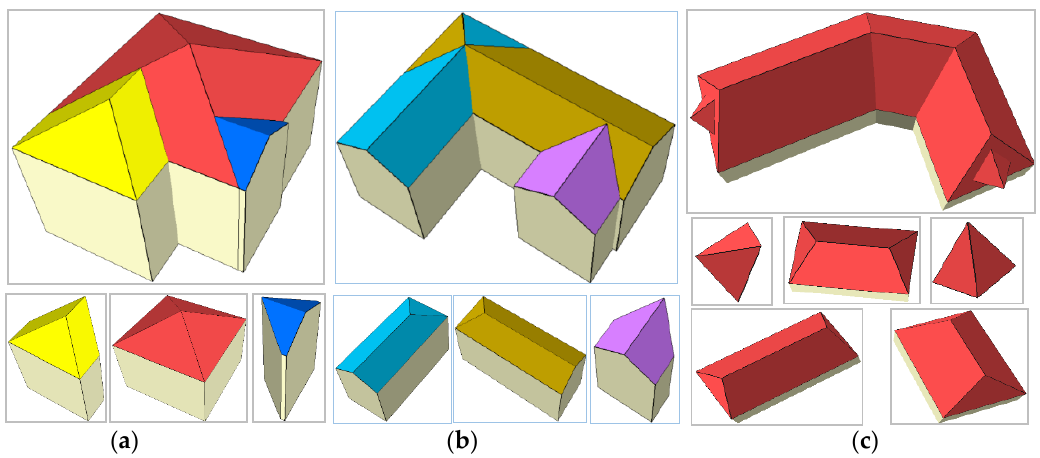
Figure 14. Results of roof reconstruction ( a – c ). Structural models ( top ) and its grouped structures ( bottom ): structures are marked with different colors; the black line is the geometric vector boundary.